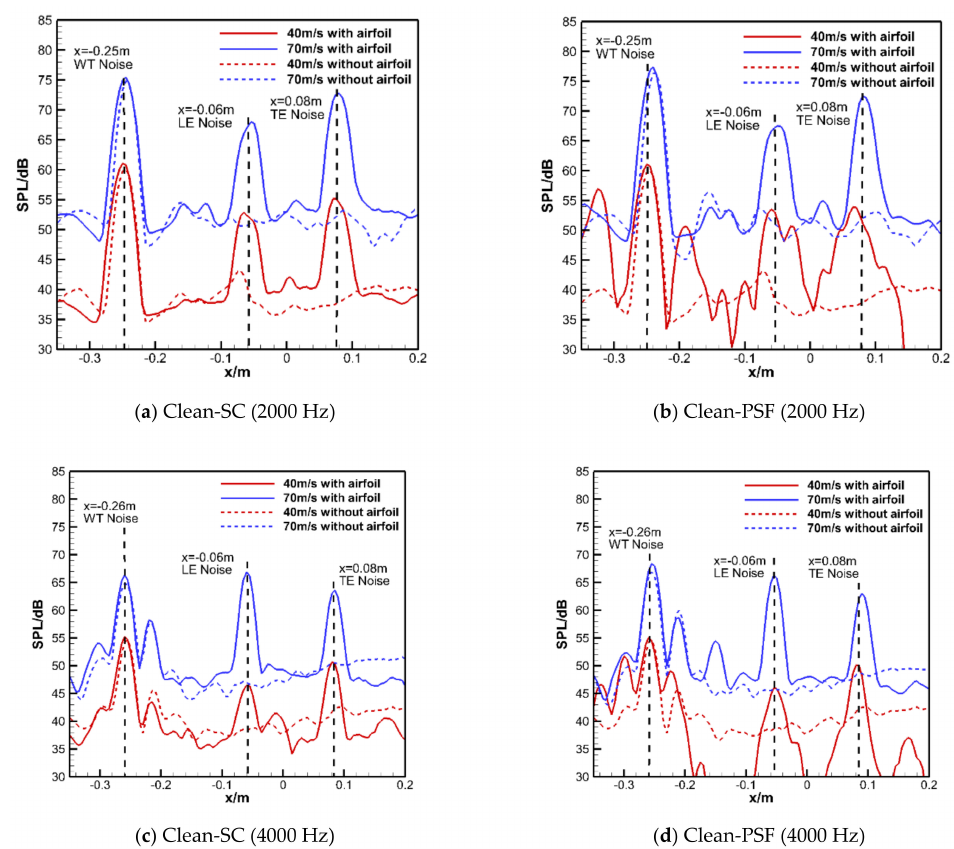
Figure 10. Comparison of the sound source identification results between Clean-PSF algorithm and Clean-SC